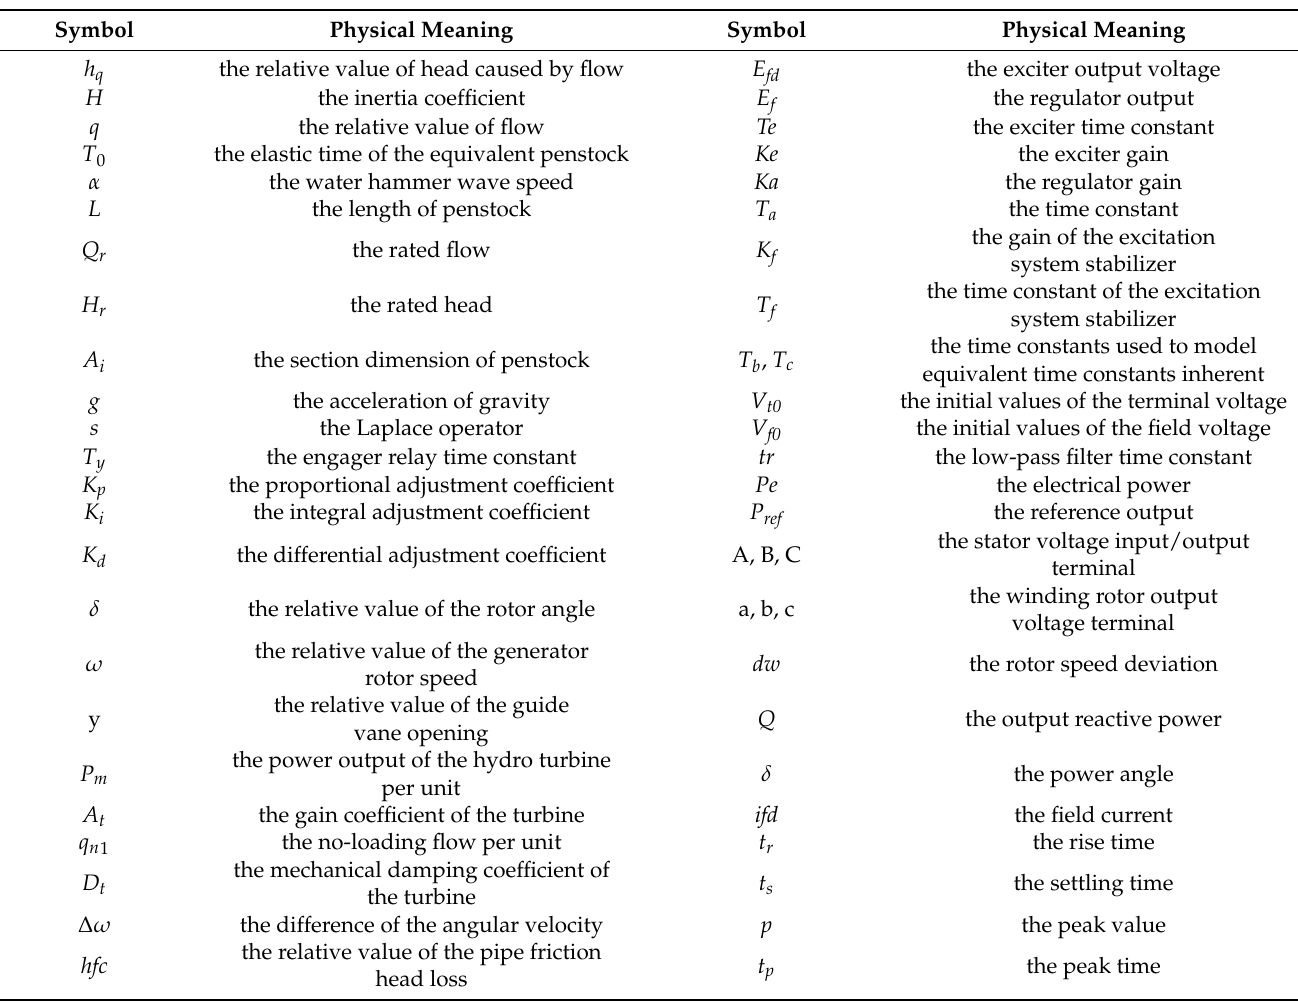
Table 3. The nomenclatures of the wind–solar − hydro hybrid